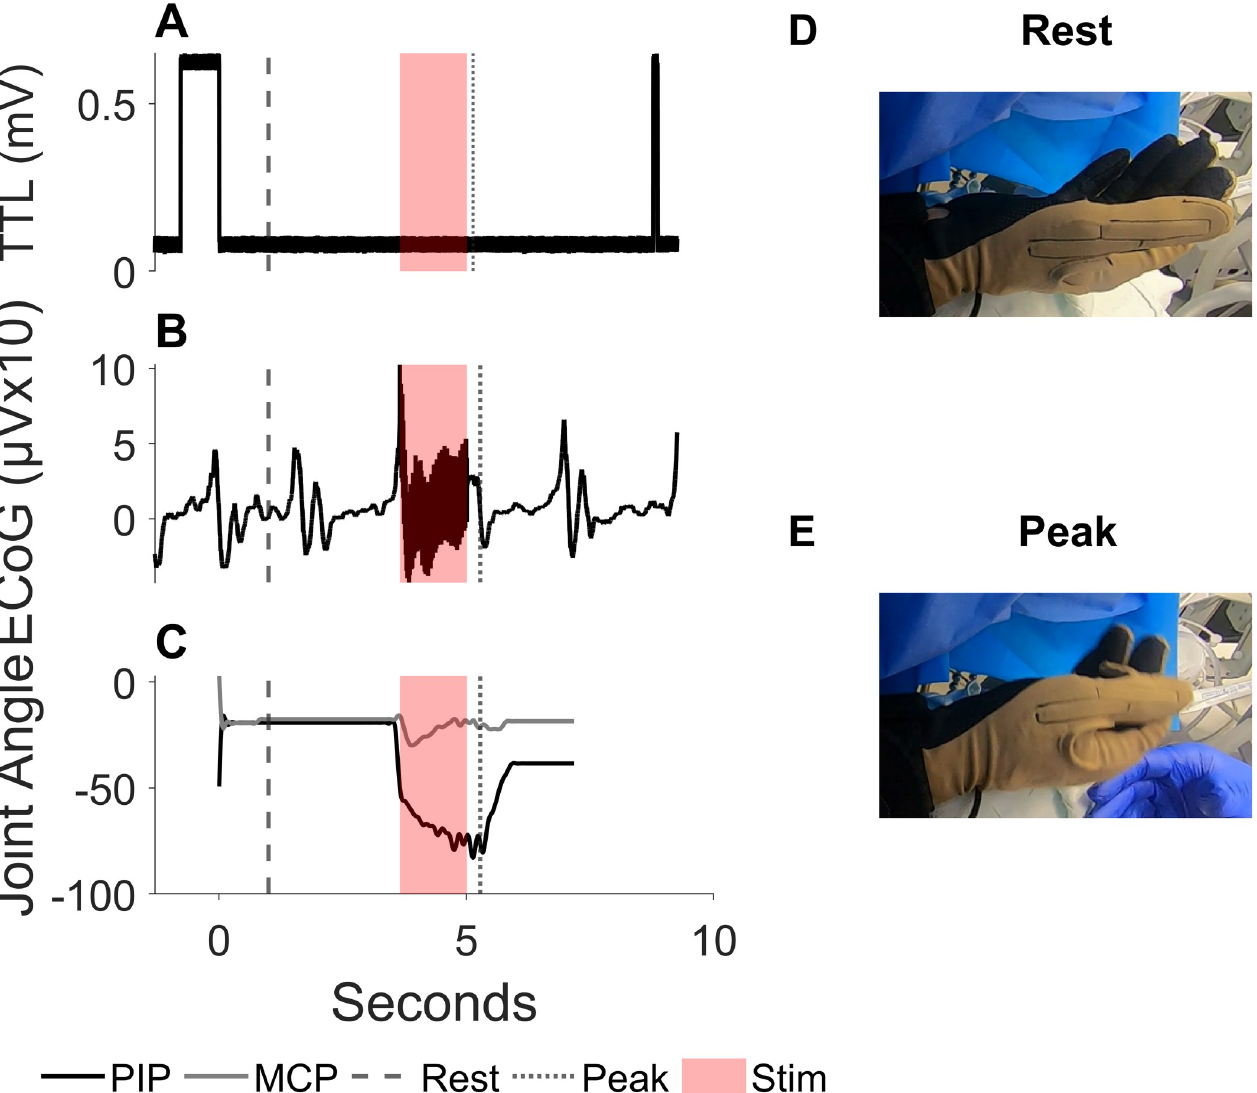
Fig 3. Sample intraoperative kinematic index flexion trial. (A) TTL voltage signal from the button press that initiates and stops recordings. (B) ECoG from one electrode during an index flexion trial in the operating room with a rest frame and peak flexion frame marked. (C) Index metacarpophalangeal (MCP) joint (gray) and proximal interphalangeal (PIP) joint (black) angle data from the index flexion trial with the rest frame and peak flexion frame marked. (D) The GoPro frame of the patient’s hand during the rest frame. (E) The GoPro frame of the patient’s hand during the peak flexion frame.